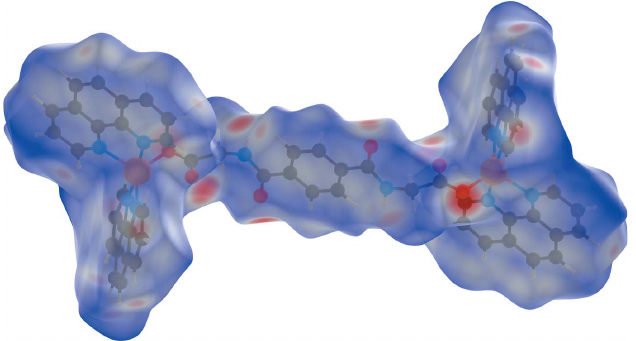
Figure 5 Graphical representation of the three-dimensional Hirshfeld surface ( d norm ) for the cationic complex plotted in the range (cid:4) 0.7078 to 1.7629 a.u.. The surface is drawn with transparency and the surface regions with strongest intermolecular interactions are drawn in red.